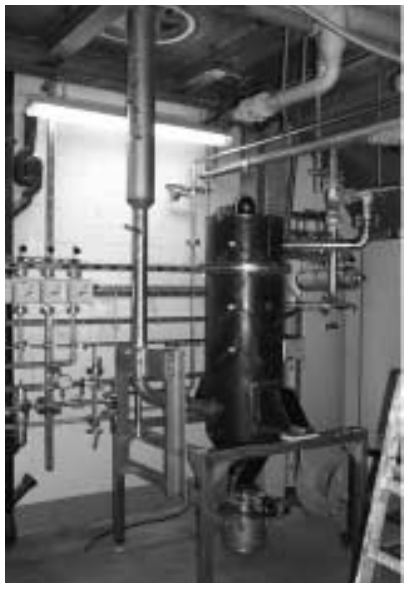
Fig. 6 Flame Reactor.